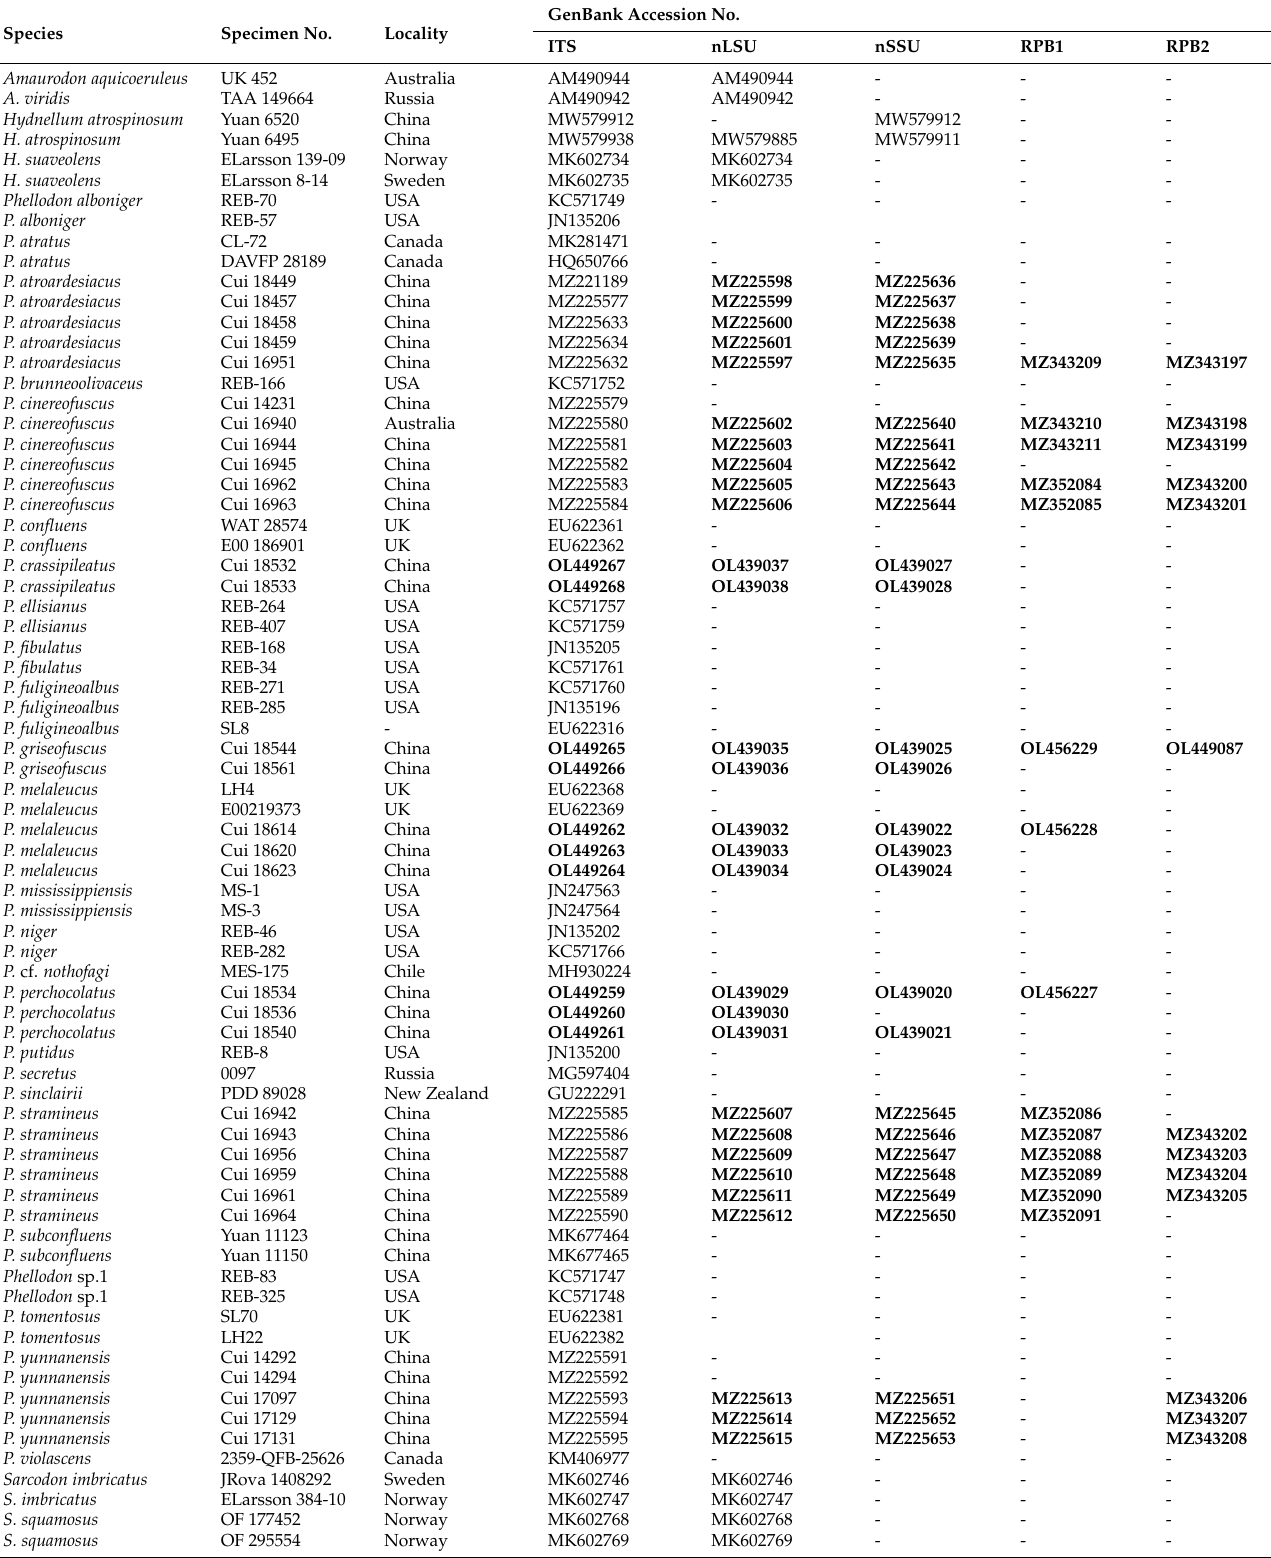
Table 1. A list of species, specimens and GenBank accession numbers of sequences used in this study. Species Specimen